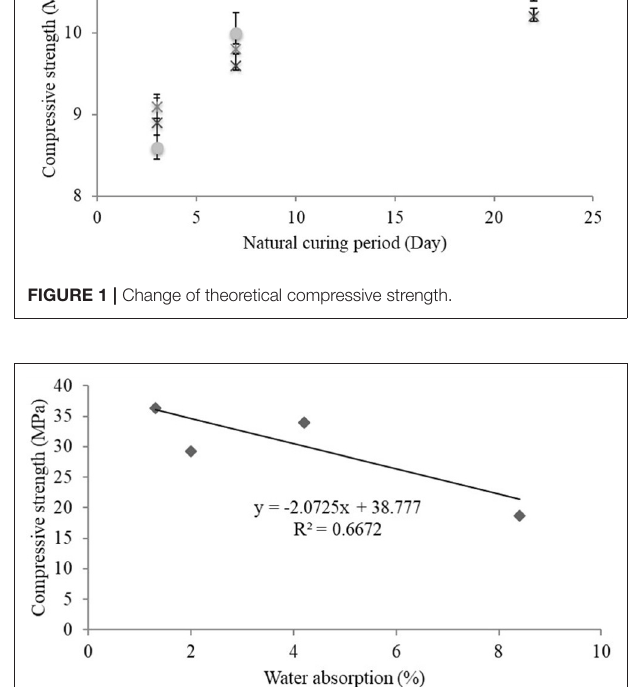
ash substitution. Singh and Siddique (2015) obtained the water absorption was fall in the range from 4.7 to 5.6% on Day 28. In addition, the author also found that the voids of bottom ash were filled Ettringites needle and a high amount of calcium silicate hydrate (CSH) gel in the bottom ash concrete on Day 90. value on Day